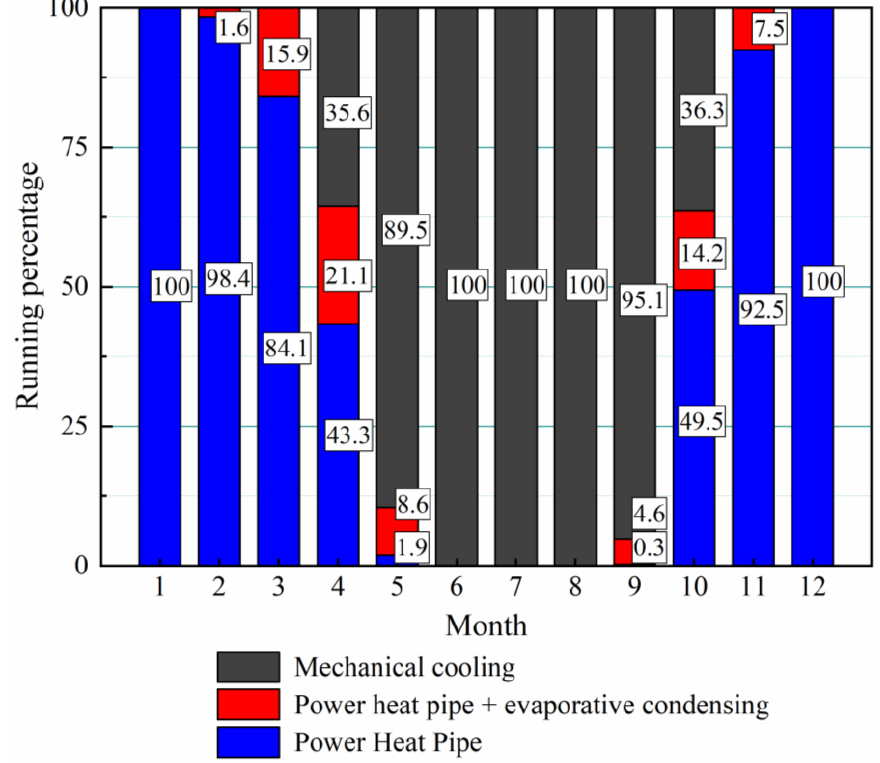
Figure 6. Monthly running time ratio of the three operation modes.